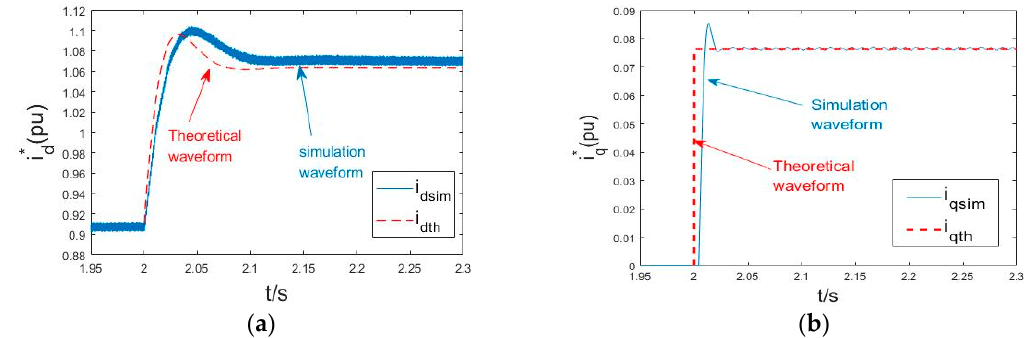
Figure 11. ( a ) Waveforms of d -axis output current. ( b ) Waveforms of q -axis output current.